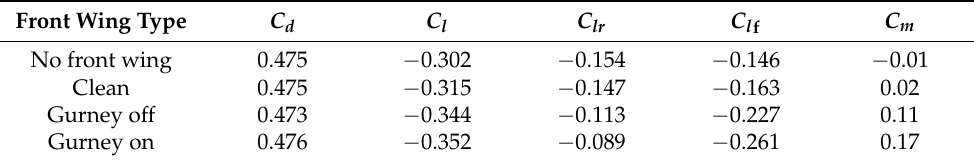
Table 3. Influence of the front wing on forces and moments.